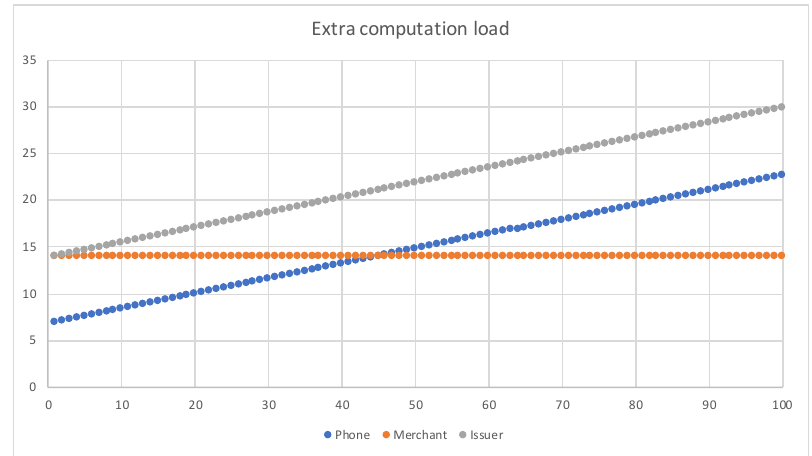
Figure 10. Extra computation